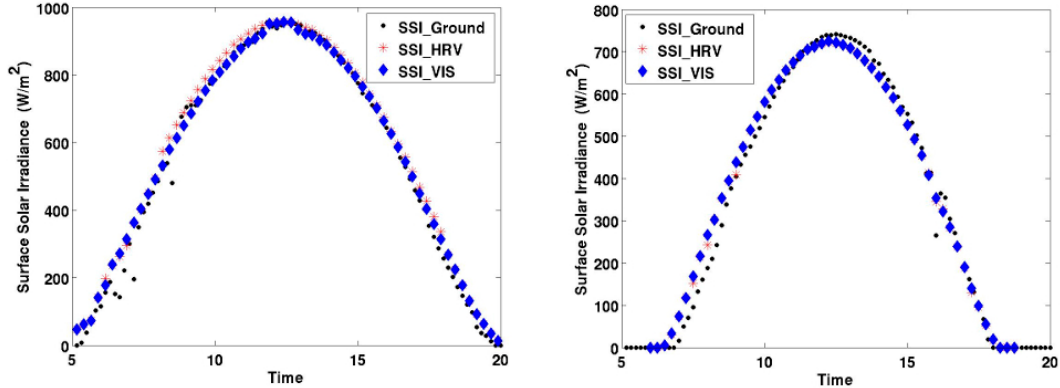
Figure 2. Surface solar irradiance estimated in clear sky by AMESIS, both SSI_HRV and SSI_VIS, and measurements by ground ‐ based pyranometers. ( Left column ): 10 June 2017 (Lat = 45.269261, Long = 9.5620594). ( Right column ): 14 March 2018 (Lat = 45.121067, Long = 10.195482).